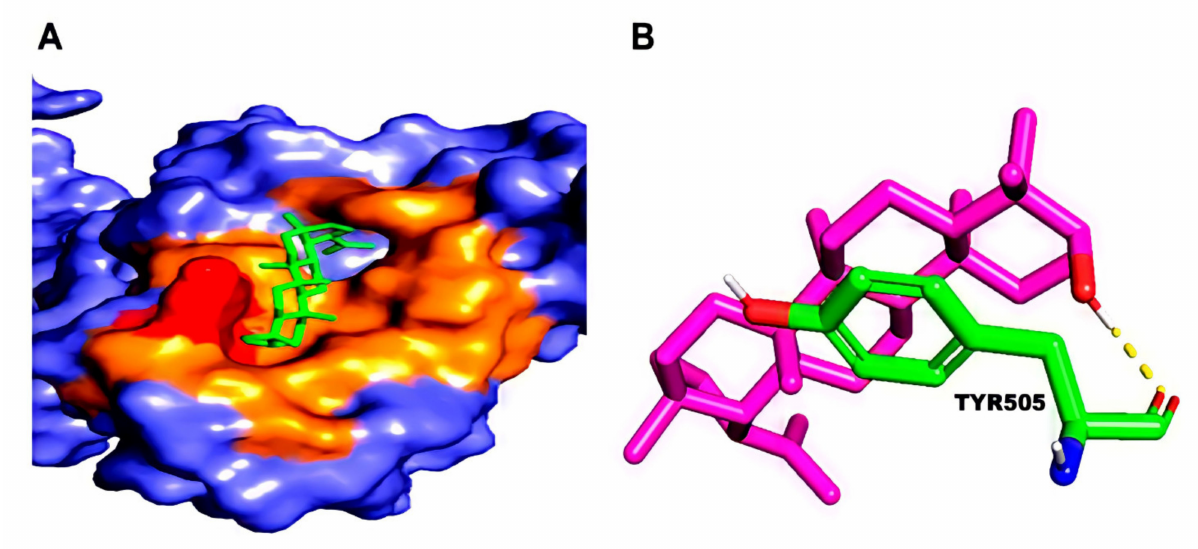
Figure 5. ( A ) Binding pose of the top-ranked phytochemical compound, Lupeol, on the surface of the wild-type Spike RBD. ( B ) 3D view of the molecular interaction between Lupeol and the residues inside the active site of wild-type SARS-CoV-2 S RBD. The hydrogen bond in the protein-ligand complex is represented by a yellow dashed